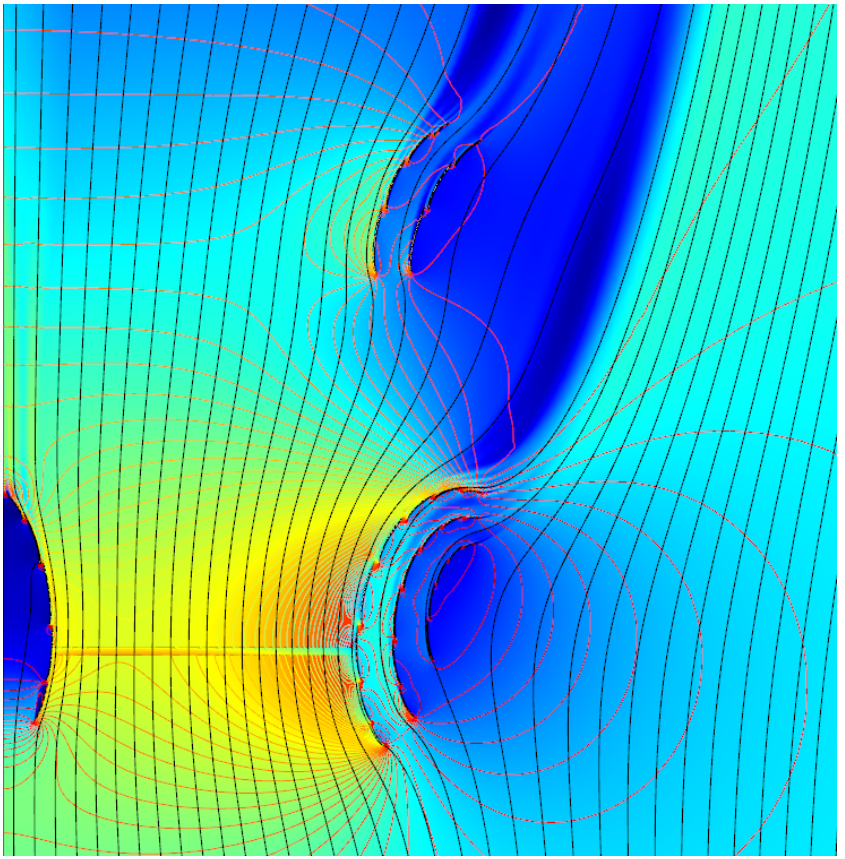
Figure 12. Cross-section (x-r plane) of the new DAWT. Black lines: Streamlines; Colored lines: iso-pressure lines. A nacelle center-body and an axisymmetric tail-section for passive yaw stability have been added to the design. The center-body causes a few percent performance losses, but the tail-section compensates for it. (cid:1866) this